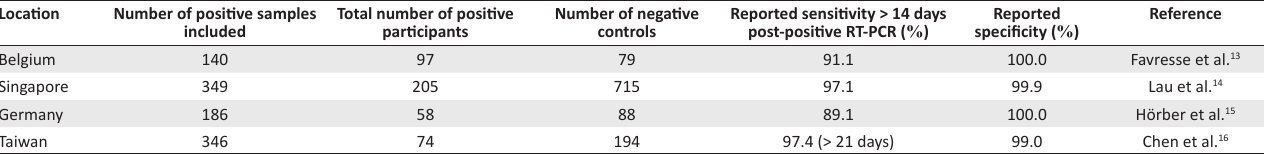
TABLE 1: Cumulative review of validations of Roche Elecsys™ severe acute respiratory virus syndrome coronavirus 2 assay. Location Number of positive samples